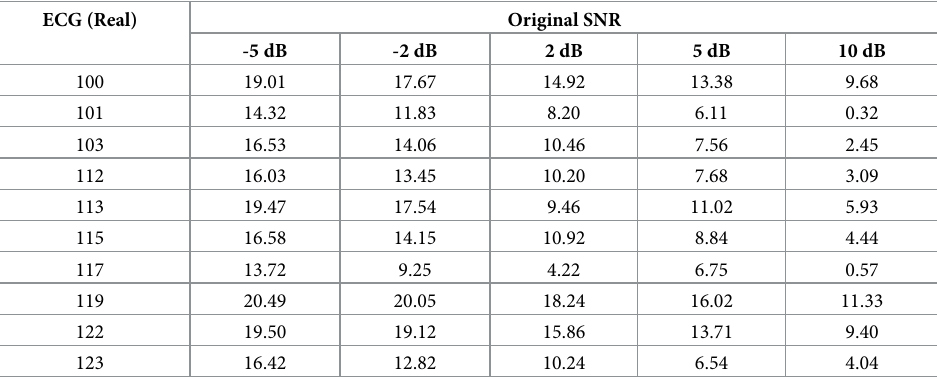
Table 4. SNR improvement from eliminating BW for real